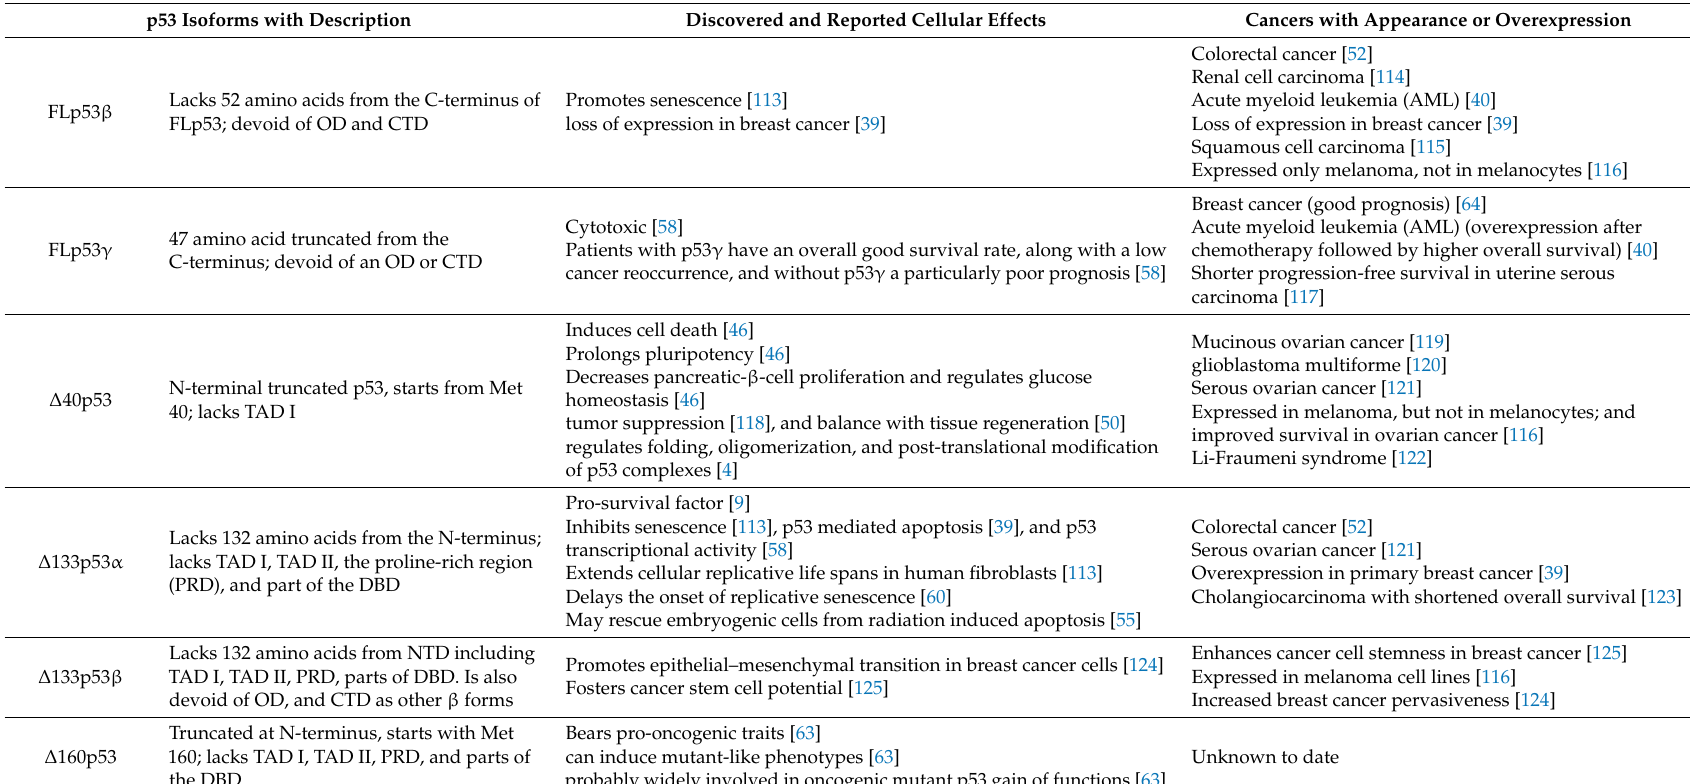
Table 1. p53 isoforms: their cellular effects and appearance in various cancer